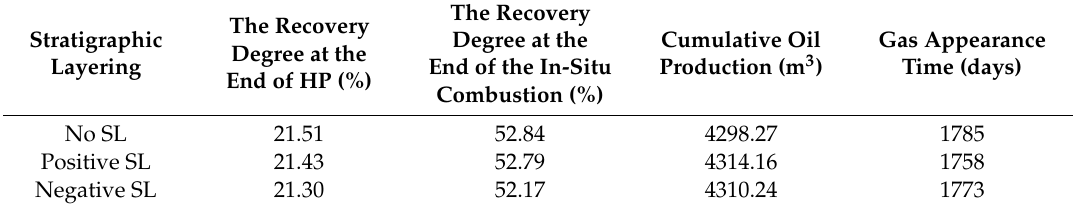
Table 14. Dynamic production indicators under different stratigraphic layering (SL).